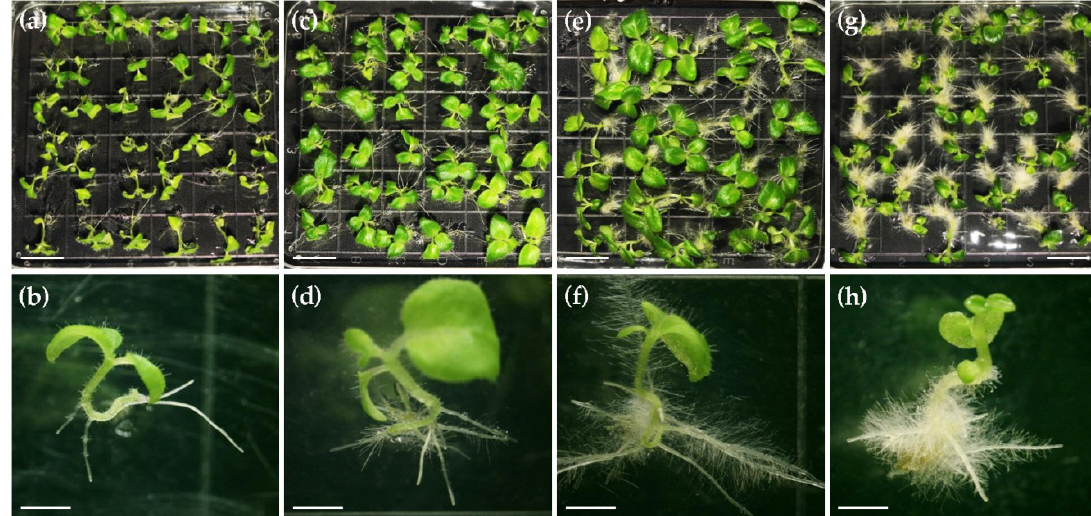
Figure 2. Effects of NAA on seedling growth. ( a , b ) Seedlings grown on medium without external phytohormone. ( c , d ) Seedlings grown on medium supplemented with 0.02 mg/L NAA. ( e , f ) Seedlings grown on medium supplemented with 0.05 mg/L NAA. ( g , h ) Seedlings grown on medium supplemented with 0.1 mg/L NAA. Scale bars: 1 cm in panels ( a , c , e , g ); 0.2 cm in panels ( b , d , f , h ).